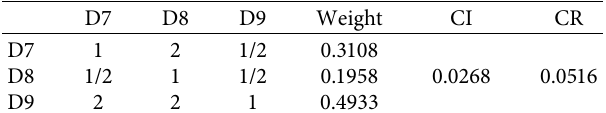
Table 5: Judgment matrix, weight allocation, and consistency test